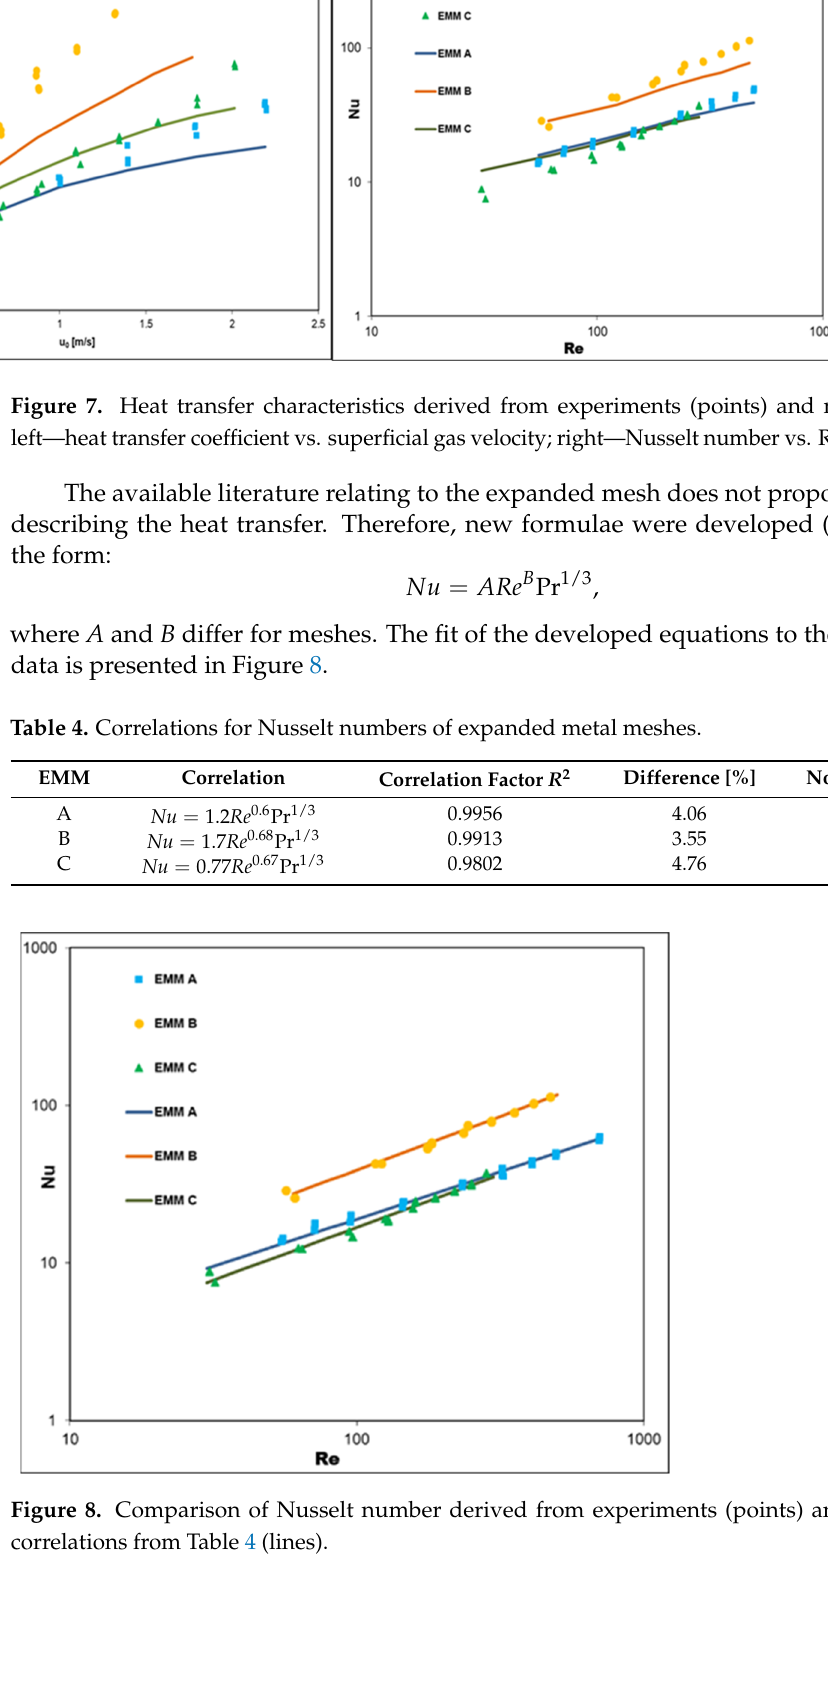
Table 5. Comparison of expanded meshes with other catalyst carriers. Support Type